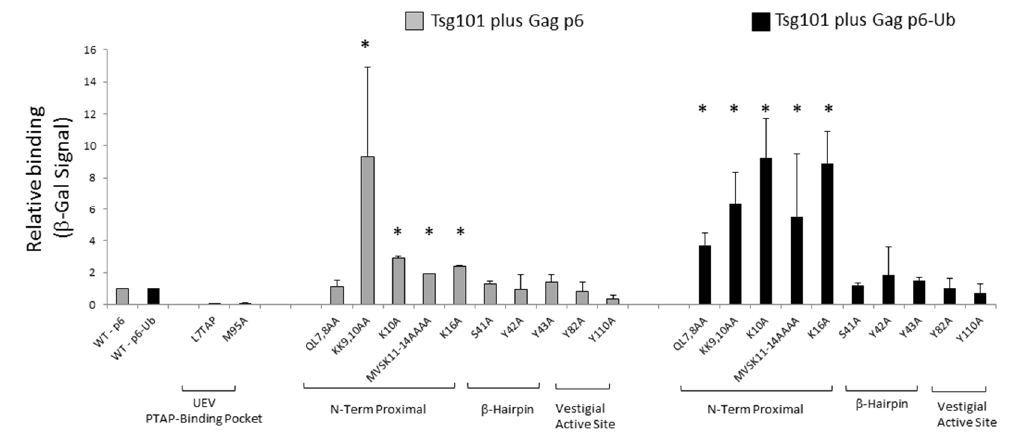
Figure 8. Mutation of tRNA binding sites permits recognition of Ub-modified Gag. The yeast 2-hybrid assay was used to measure the relative binding for p6 plus Tsg101 wild-type or mutants and p6-Ub plus Tsg101 wild-type or mutants. The figure shows the average for transformants representing two or three isolates for each mutation. The asterisks indicate the mutants that were di ff erent from Tsg101 WT by Student’s t -test (* p < 0.05). For each assay, wild-type controls ( n = 3) were run in parallel with experimental samples and were used to normalize values. Controls also included Gag p6 L 7 TAP plus Tsg101 wild-type (negative control) and Gag p6 2xPTAP plus Tsg101 wild-type (positive control) for each assay.